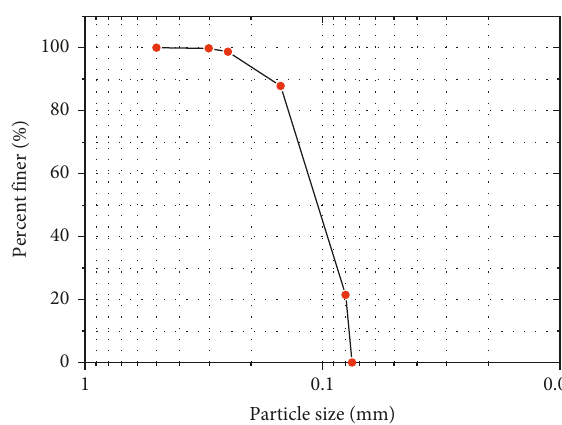
Figure 5: Experiment setup. (a) Setup. (b)